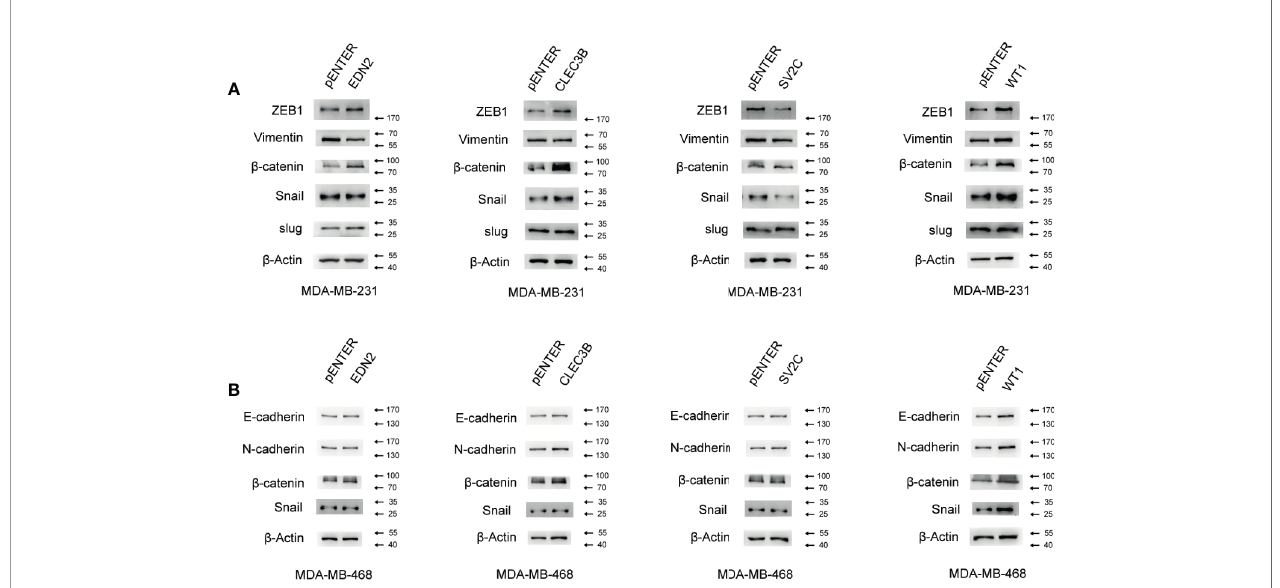
FIGURE 10 | In fl uence of the selected genes on the EMT signaling pathway in breast cancer. (A) Effect of the selected genes on the protein level of the EMT signaling pathway was measured by Western blot assay in MDA-MB-231. (B) Effect of the selected genes on the protein level of the EMT signaling pathway was measured by Western blot assay in